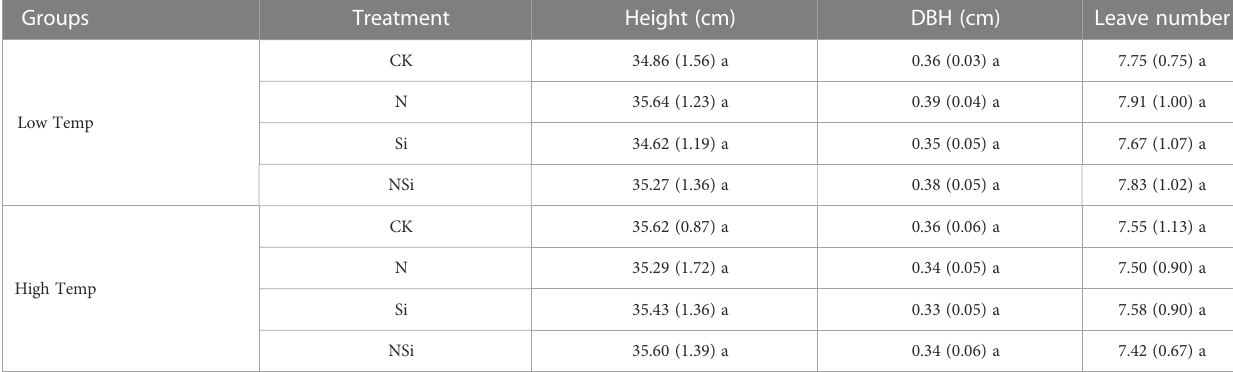
TABLE 2 Characters of Moso bamboo seedlings for different temperature groups and fertilization treatments.